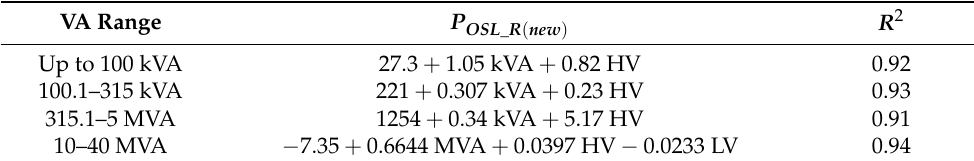
Table 6. Novel regression models for P OSL _ R ( new ) .